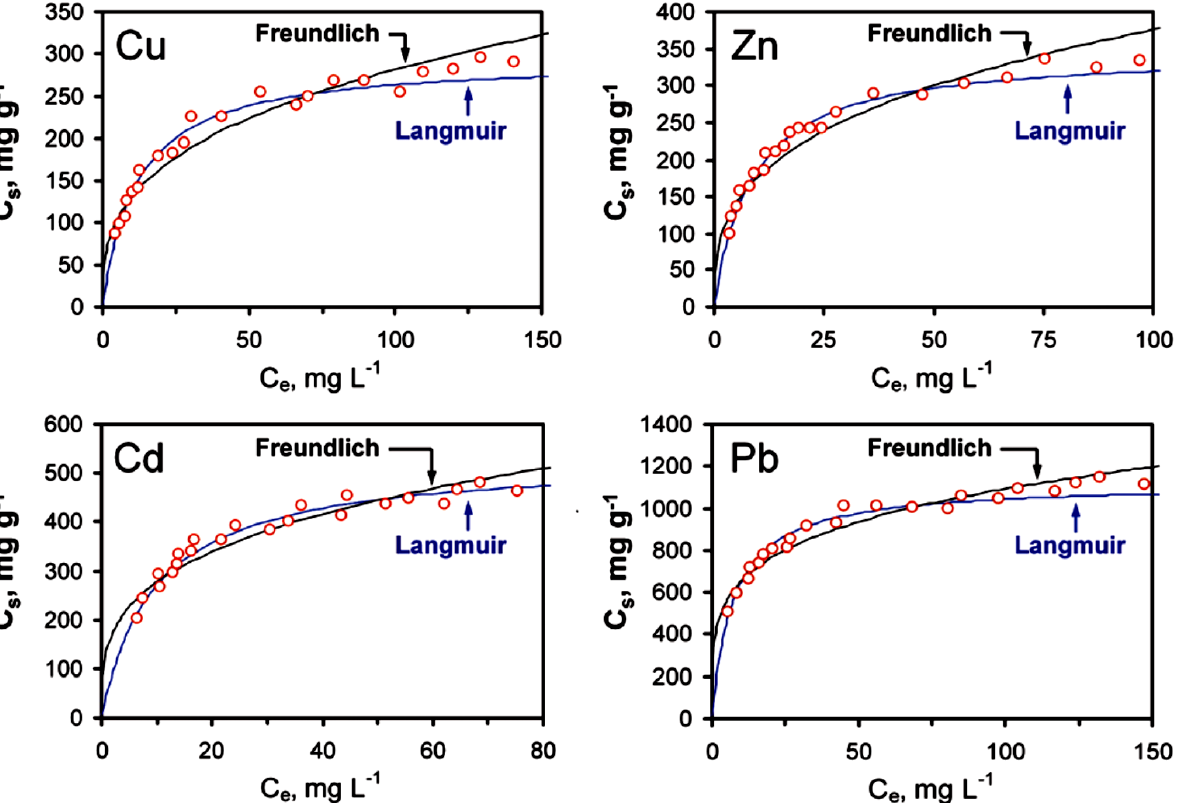
Figure 5. Langmuir and Freundelich isotherms, where the dotted lines represent the individual plots from which the best fit curves were fitted (Adapted with permission from ref. [69]. Copyright 2013 RCS publishing.)